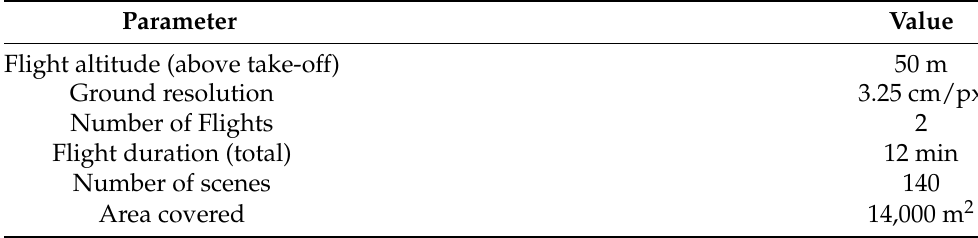
Table 2. Acquisition parameters for flight operations on the scanned